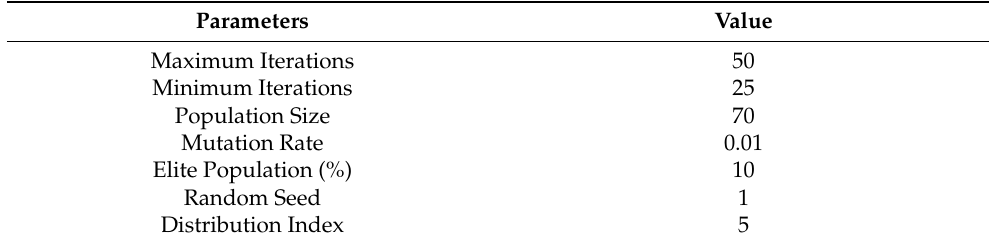
Table 5. Relative parameters of